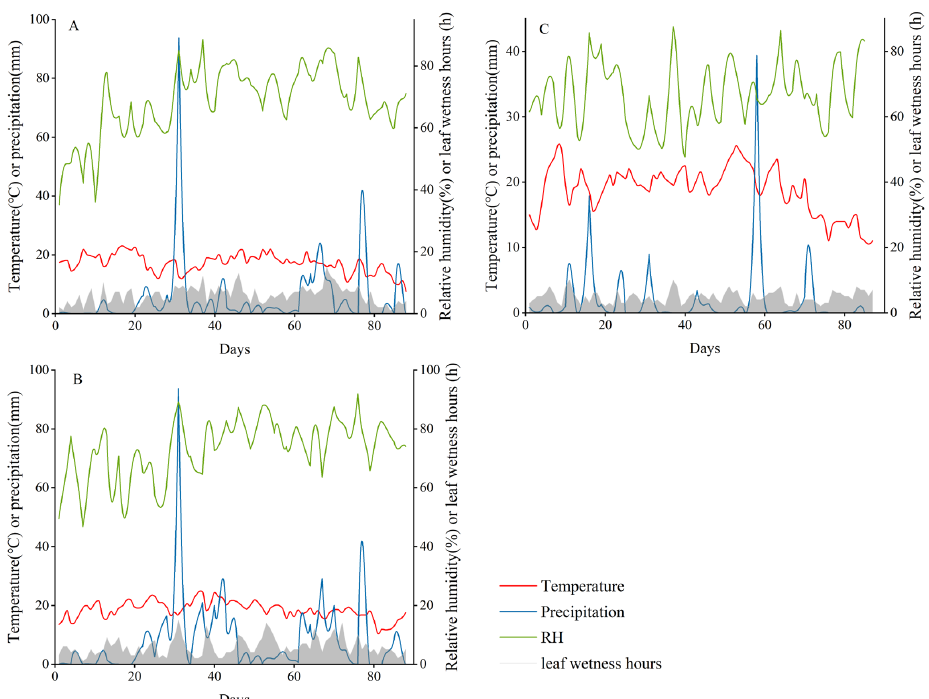
Figure 1. Leaf wetness hours, relative humidity, air temperature, and precipitation were measured daily by a weather station in the experiments conducted from June to August of 2020 ( A ), 2021 ( B ), and 2022 ( C ).